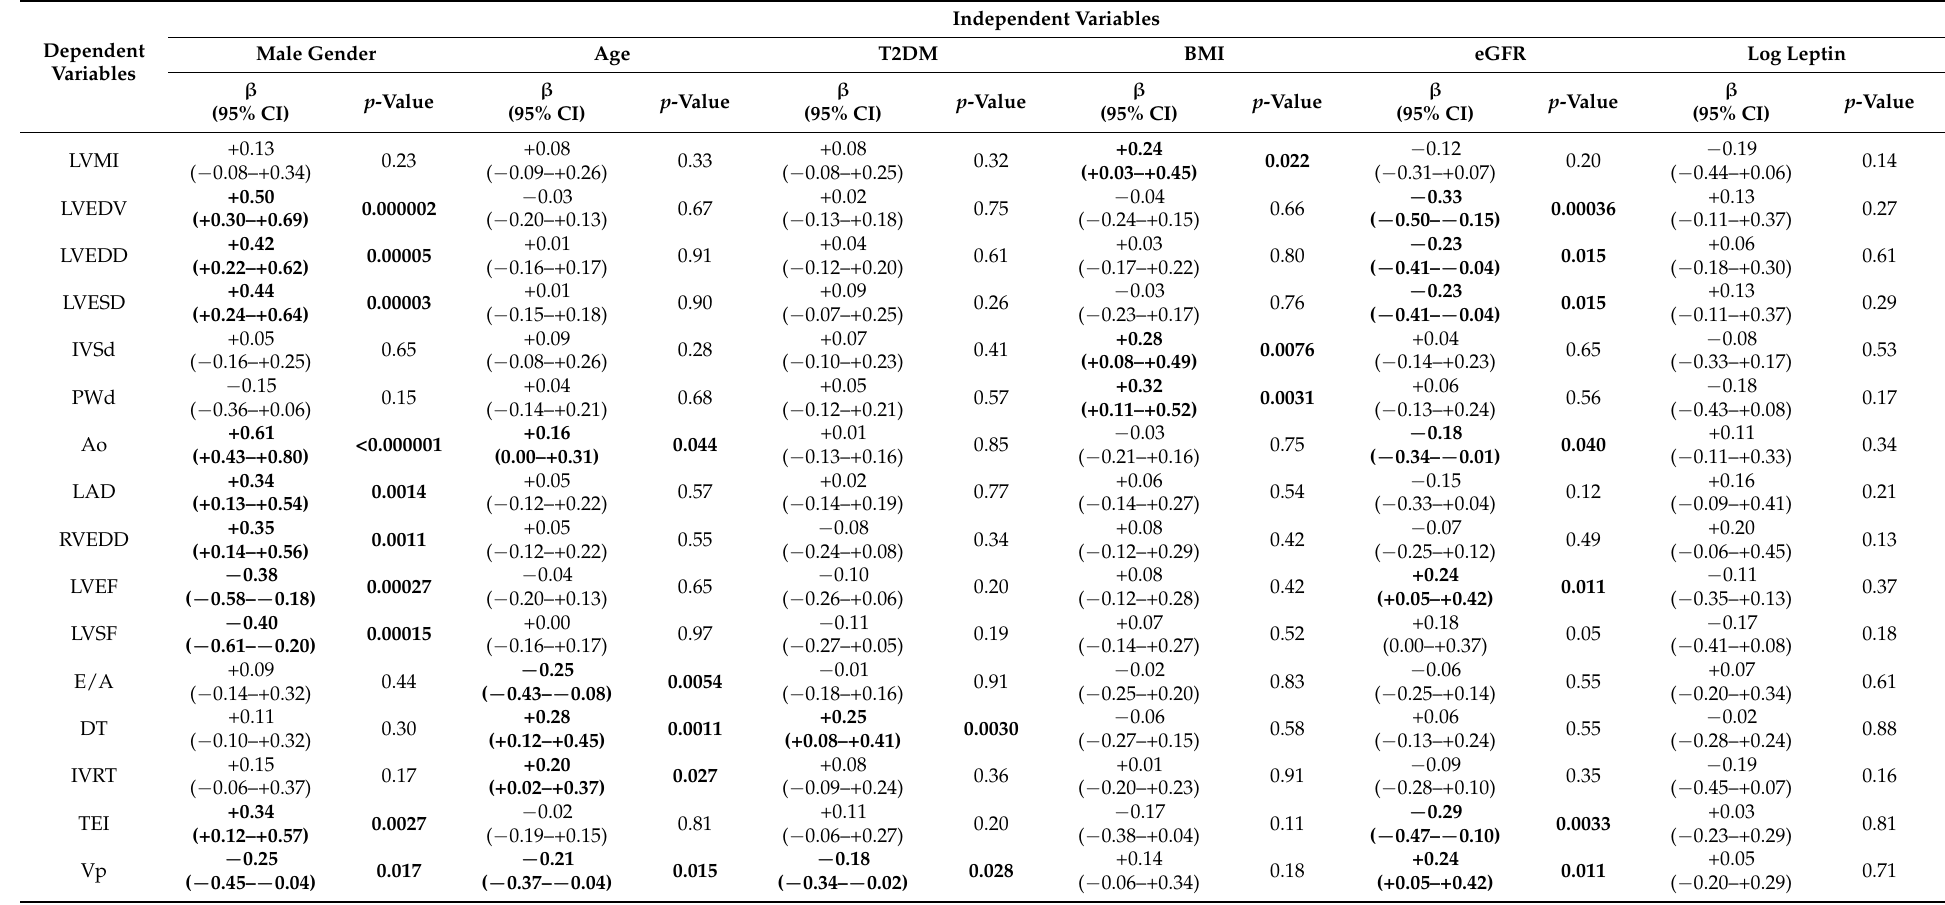
Table 4. Multivariate linear regression models for echocardiography parameters as dependent variables and male gender, age, T2DM, BMI, eGFR and logarithm of plasma leptin concentration as independent